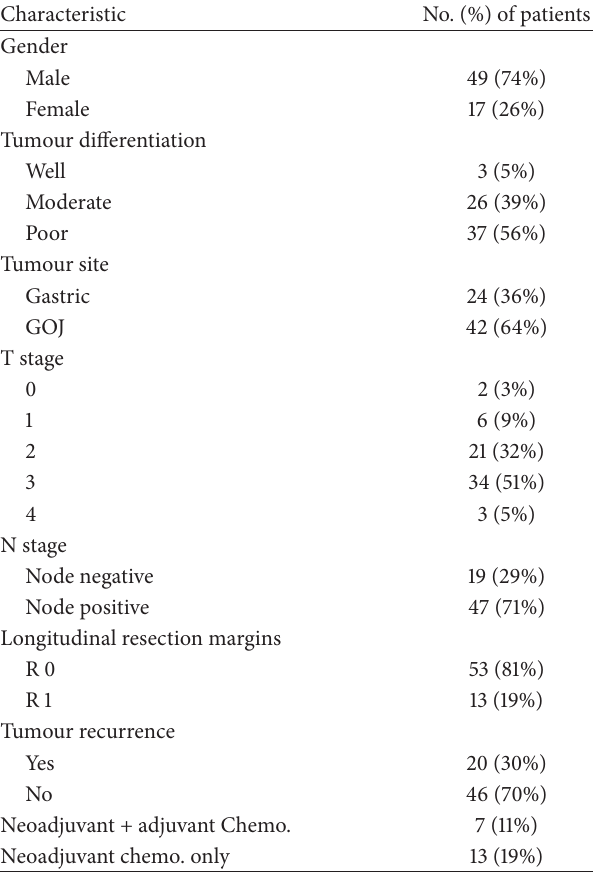
Table 1: Patient characteristics.